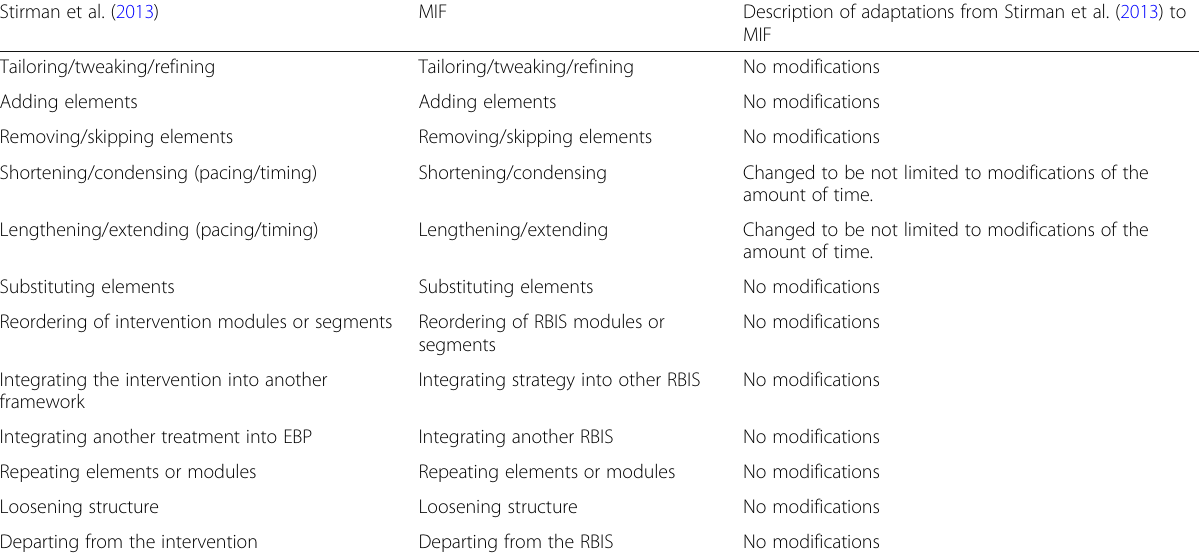
Table 9 Instructional practice changes — nature of modification Stirman et al. (2013)